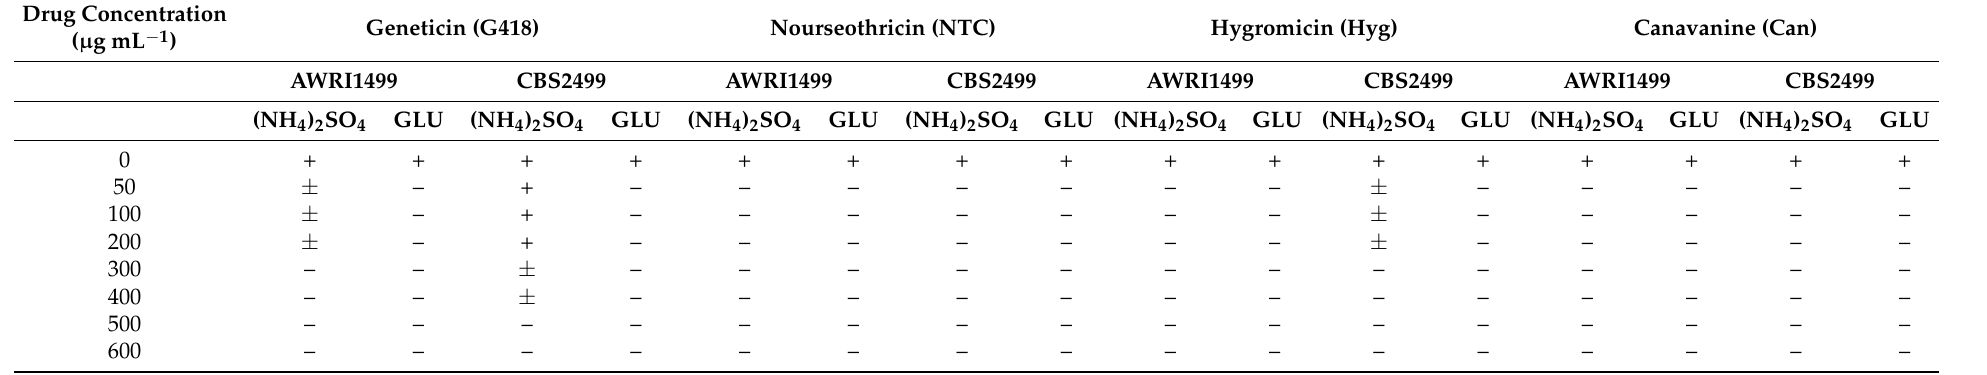
Table 3. Test for drug sensitivities on yeast nitrogen base (YNB) medium without amino acids supplemented with 5 g L − 1 ammonium sulfate [(NH 4 ) 2 SO 4 ] or 1 g L − 1 L–glutamic acid (GLU) as a nitrogen source. Drug